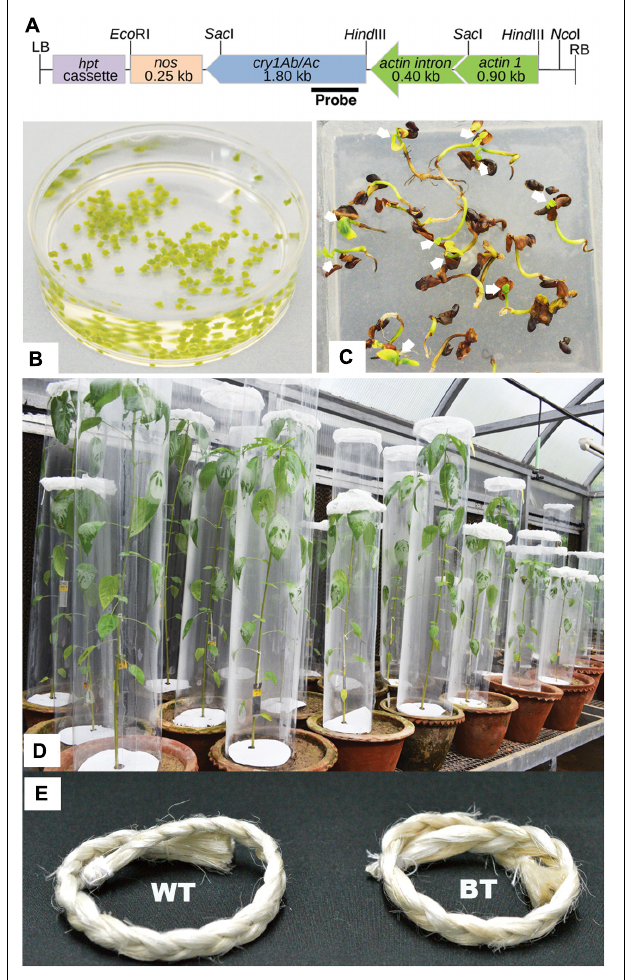
FIGURE 1 | Stages of Bt jute development. (A) Schematic map of transformation vector pCAMBIA1301- actin-cry1Ab/Ac-nos (without gus ) containing rice actin constitutive promoter (with its first intron), fused cry1Ab/Ac gene and nos terminator. Marked site for Nco I and portion in the gene was used as probe for Southern analysis (B) Isolated shoot tips from 5 day-old plants in infiltration media containing LBA4404 Agrobacterium cells. (C) Transformants (arrow marked) selected in hygromycin-B containing MS media remain healthy whereas non-transformed seedlings show browning and die. (D) Each transgenic plant of 90 DAS age, was subjected to WPB in the greenhouse with 10, second instar larvae. (E) Fibers of Bt jute and WT (non-transgenic) were compared after extraction where no significant differences were found in color, texture and